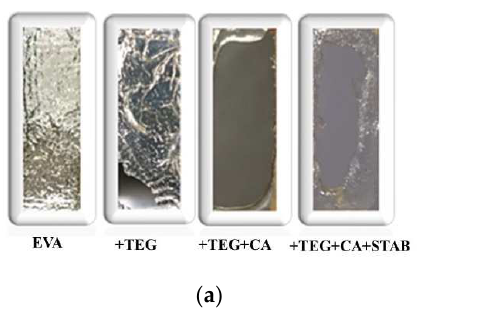
Figure 7. Pictures of the ( a ) EVA and ( b ) EVA/PO = 75/25 wt.% samples with and without an adhesion promoter (TEG), a crosslinking agent (CA) and stabilizers (STAB) at maximum photo- degradation time.